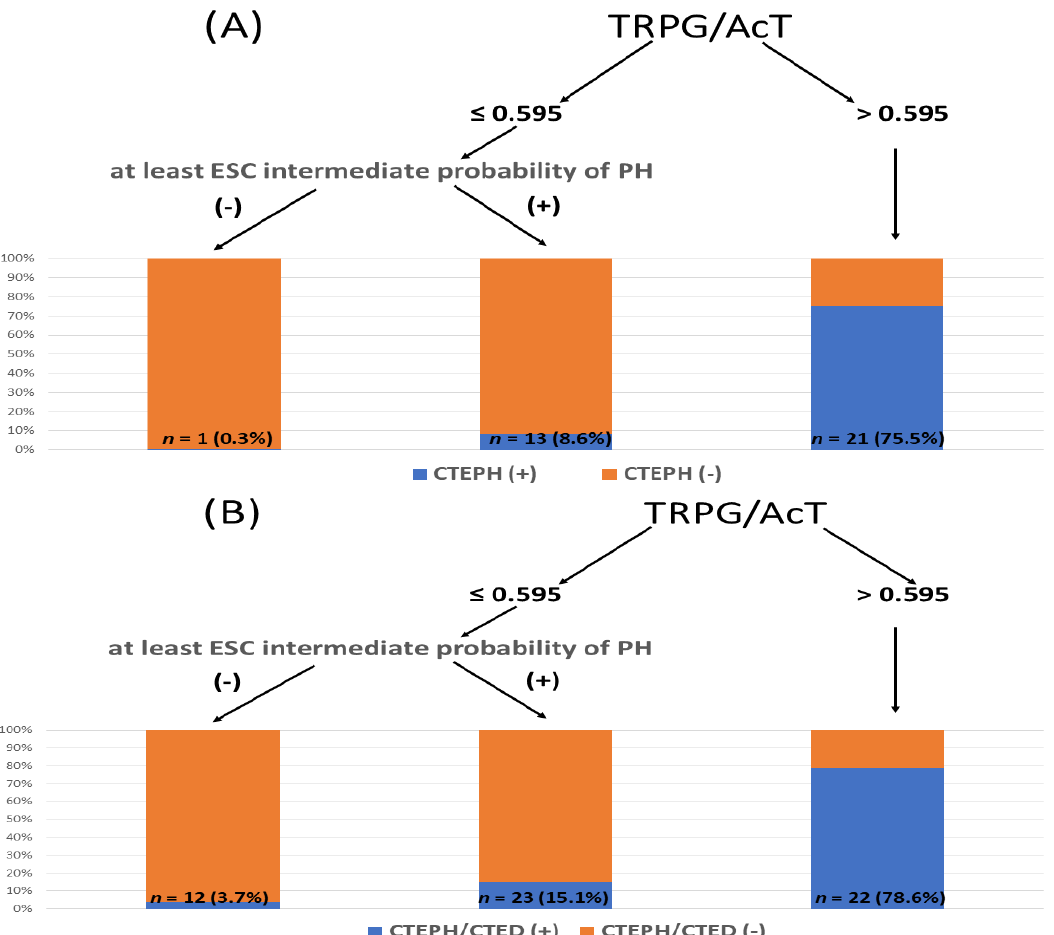
Figure 4. Echocardiographic diagnostic algorithm of CTEPH and CTED in pulmonary embolism survivors with functional impairment: ( A ) for CTEPH, ( B ) for combined CTEPH with CTED. AcT—pulmonary ejection acceleration time, CTED—chronic thromboembolic disease, CTEPH—chronic thromboembolic pulmonary hypertension, ESC—European Society of Cardiology, TRPG—tricuspid regurgitation peak gradient, PH—pulmonary hypertension.